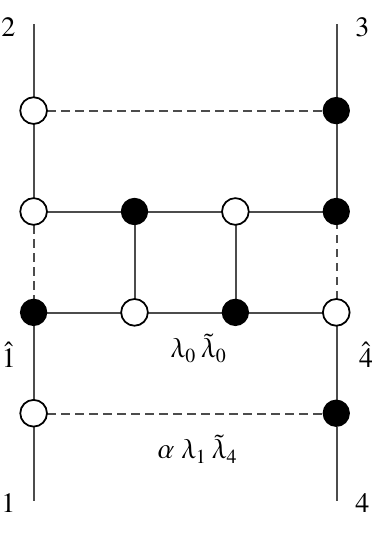
Figure 19 . On-shell diagram for 1-loop four-point amplitude in N =8 SUGRA.